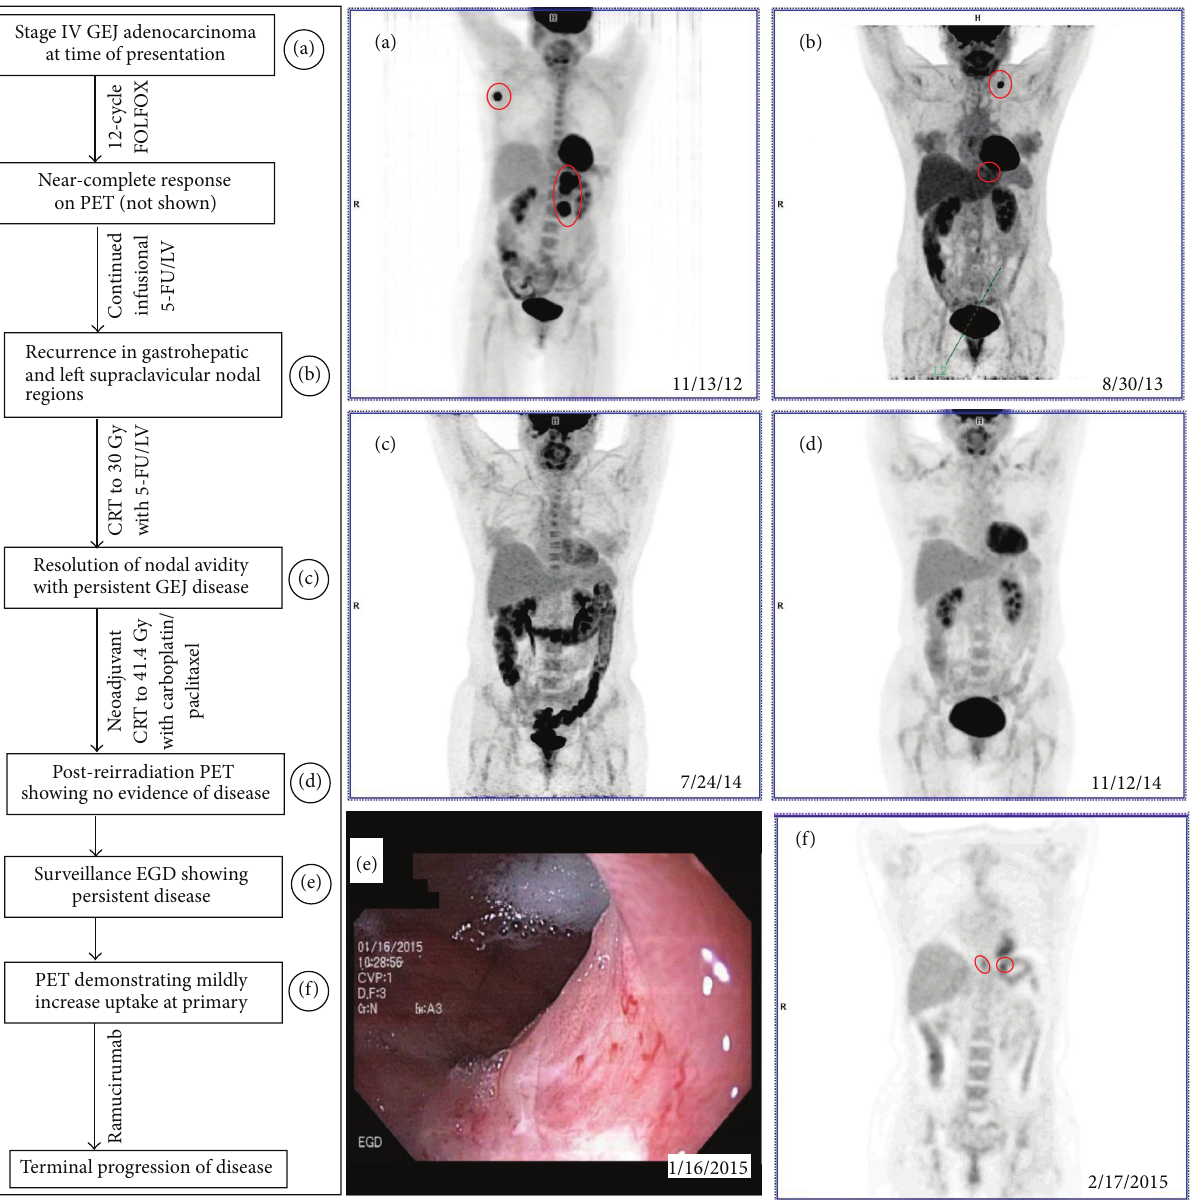
Figure 1: Selected PET/CT scans. (a) Initial PET/CT at the time of diagnosis showing uptake in GEJ, left para-aortic lymph nodes (SUV 11.8), and right axillary lymph nodes (SUV 10.8). (b) Surveillance PET/CT showing recurrence in the left supraclavicular fossa (SUV 23.3) and gastrohepatic nodal region (SUV 2.6). (c) PET/CT prior to second course of radiotherapy showing no residual metabolic uptake outside of the primary. (d) PET/CT post-reirradiation to the GEJ primary. (e) Shallow ulceration of GEJ with pathology demonstrating persistent adenocarcinoma. (f) Red circles highlight areas of increased uptake. Corresponding dates are shown.